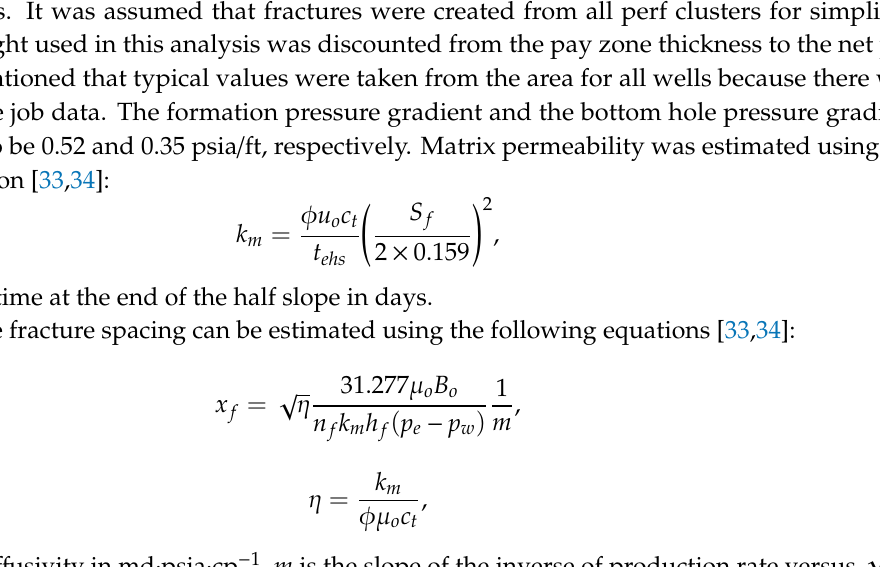
Figure 8. Plot of production rate data for Well #3.